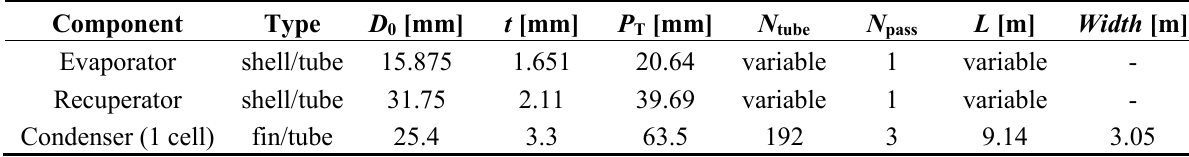
Table 1. Geometrical dimensions of heat